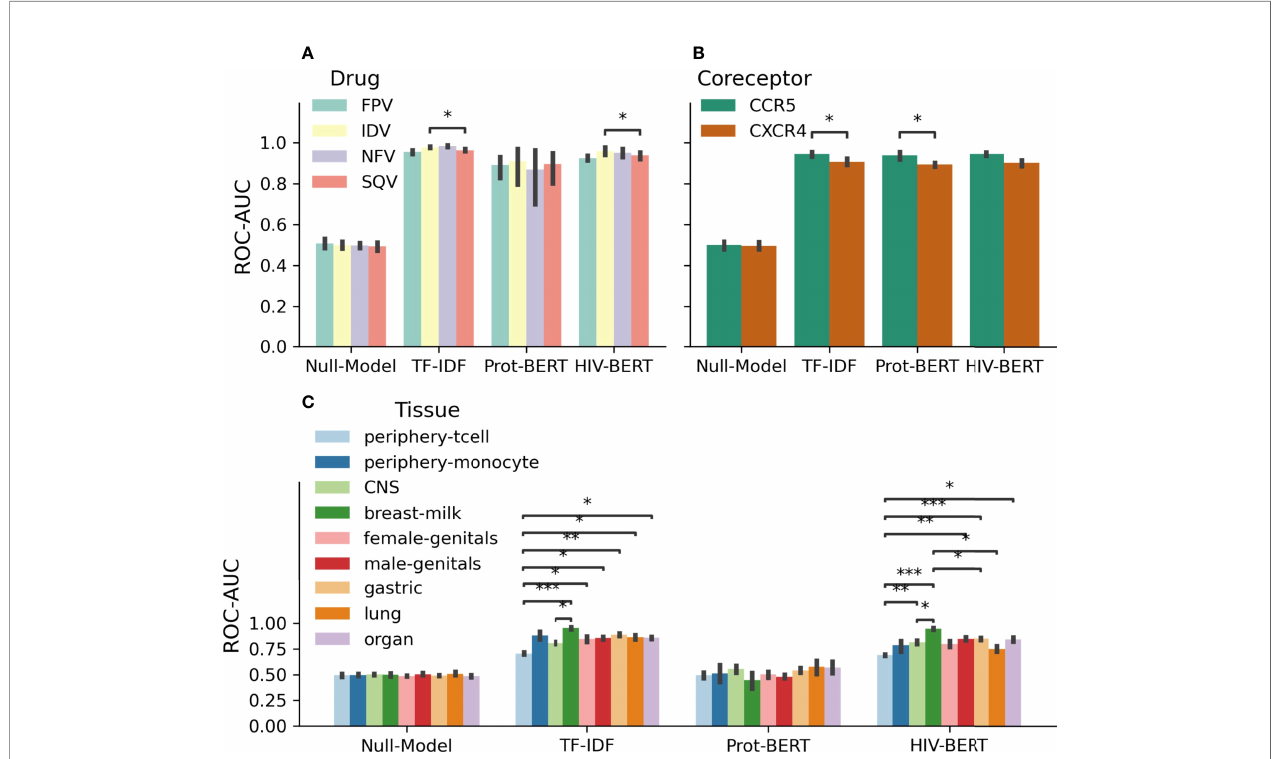
FIGURE 4 | Area under the curve (AUC) scores for individual fi elds of drug resistance and coreceptor prediction are consistent, but tissue identi fi cation is not. The model AUC scores were disambiguated for each fi eld of each prediction task. Each task is shown in (A) protease drug resistance, (B) coreceptor prediction, and (C) tissue isolation with colors indicating the prediction fi eld. The bar indicates the mean value and the error bars represent the 95% con fi dence interval of 5-fold cross validation. The test- comparison bars represent the results of a paired t-test between each group; undrawn comparisons p<0.05, *(0.05<p<=0.01), **(0.01<p<=0.001), ***(0.001<p<=0.0001), ****(p<=0.00001). A Bonferroni correction based on all possible tests in the fi